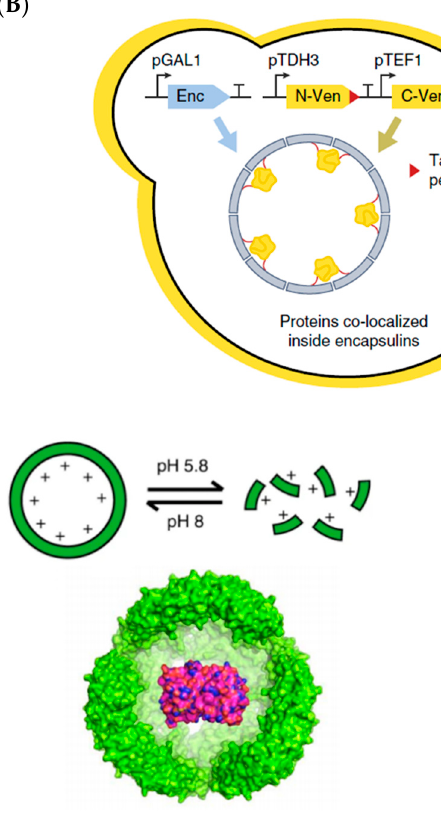
Figure 5. Nanoscale protein compartments from bacteria and archaea can be engineered to house enzymes. ( A ) Structural model of how cargo proteins are encapsulated by the T. maritama encapsulin shell. The C-terminal EP sequence (colored red) of the Flp protein docks into a hydrophobic pocket on the interior of the shell. Reprinted from Ban and co-workers [69]. ( B ) Assembly of A. fulgidus ferritin shells were engineered to be pH-responsive, allowing easy encapsulation of guest proteins (colored red/blue) in vitro. Reprinted from Drum and co-workers [15]. ( C ) The M. xanthus encapsulin shell was produced in S. cerevisiae and was capable of co-localizing split proteins. Reprinted from Silver and co-workers [51]. Copyright ( A ) 2008, ( B ) 2017, and ( C ) 2018 Nature Research.